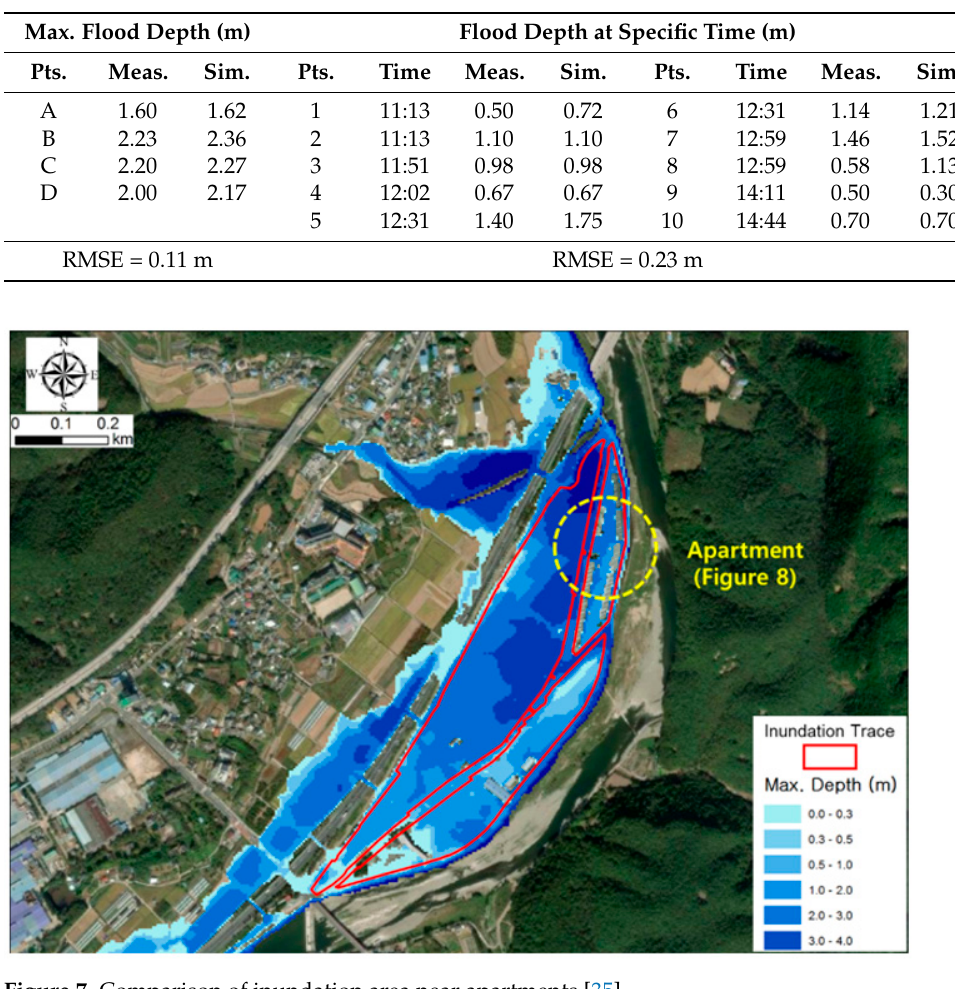
Figure 7. Comparison of inundation area near apartments [35].